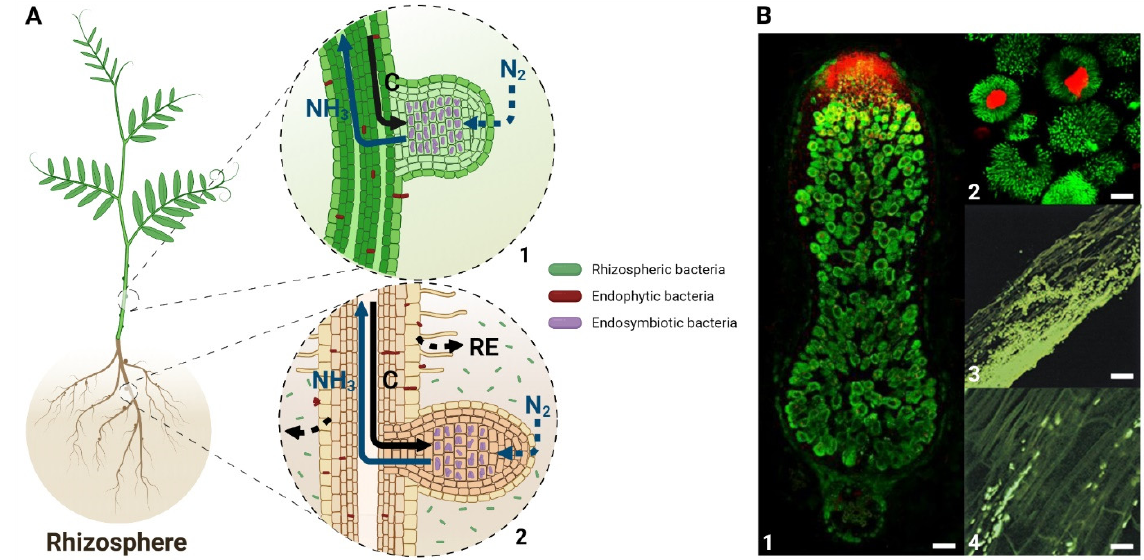
Figure 1. Colonization patterns of endosymbiotic and endophytic bacteria in interaction with the plant. ( A ) Schematic representation of bacterial distribution within the plant. Rhizospheric bacteria (green) spread into the rhizosphere but do not directly interact with plant tissues. Endophytic bacteria (red) colonize the plant surface and intercellular space of plant tissues. Endosymbiotic bacteria (purple) are able to induce the formation of the stem ( A1 ) or root ( A2 ) nodules containing nitrogen-fixing bacteroids. In exchange for the ammonia provided by these endosymbiotic bacteria, plant transfer carbohydrates derived from photosynthesis. N 2 : atmospheric nitrogen; NH 3 : ammonia; C: carbohydrates; RE: root exudates. ( B ) Pictures of endosymbiotic and endophytic bacterial distribution within plants. For endosymbiotic bacteria, Live/Dead microscopic analysis of mature nodules ( B1 ) and infected cells in zone III ( B2 ) formed during M. truncatula / S. meliloti symbiosis is represented. For endophytic bacteria, longitudinal sections of a maize root colonized by GFP-labelled Klebsiella pneumoniae ( B3 ; B4 ) are represented reprint from reference [9] with kind permission from the American Society for Microbiology. Scale bar: 100 µm ( B1 ), 10 µm ( B2 ; B4 ), or 20 µm ( B3 ).